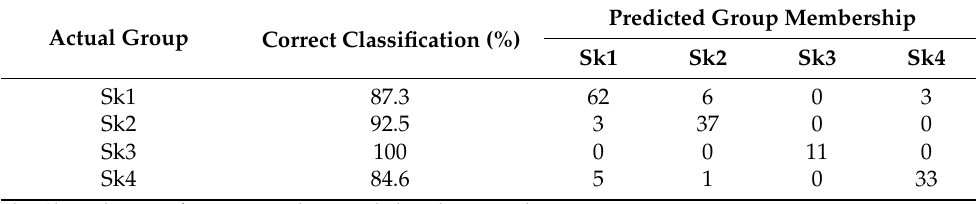
Table 2. Classification results of LDA presenting percentage predicted group membership for actual groups.